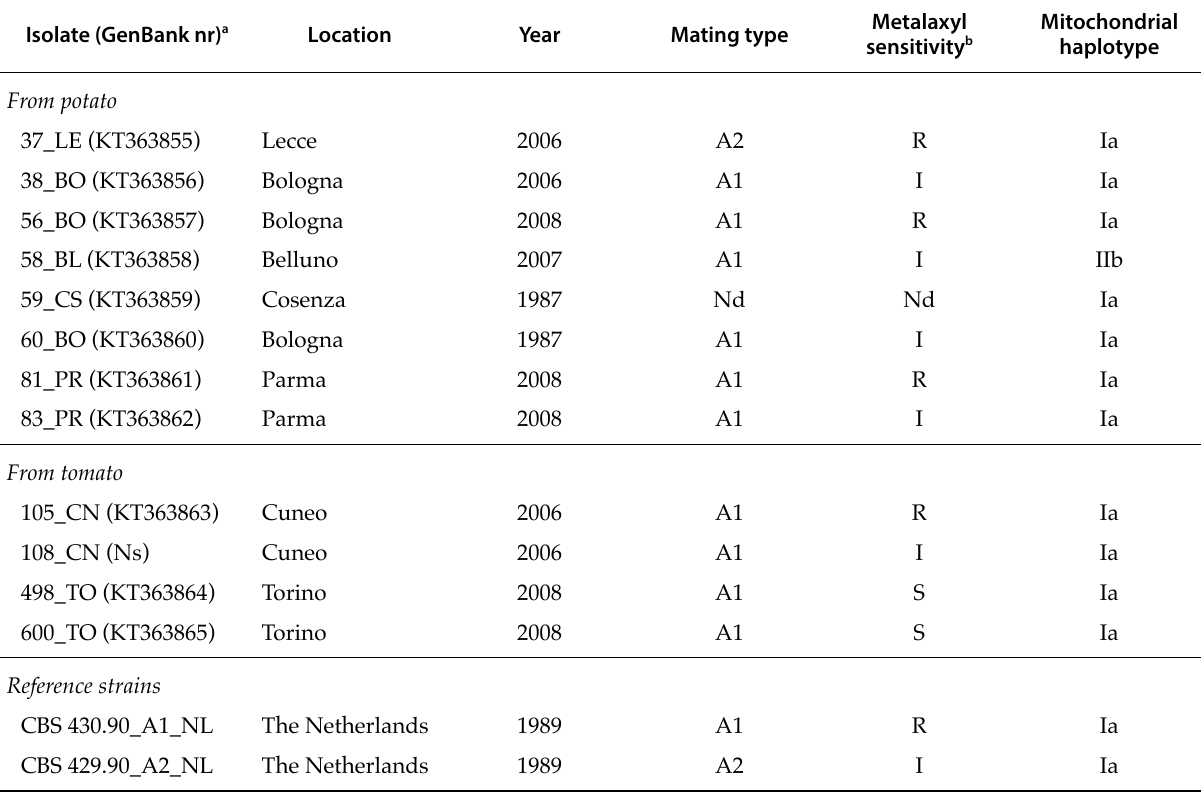
Table 1. Phytophthora infestans isolates, locations, year of harvesting, mating type, metalaxyl sensitivity and mitochondrial